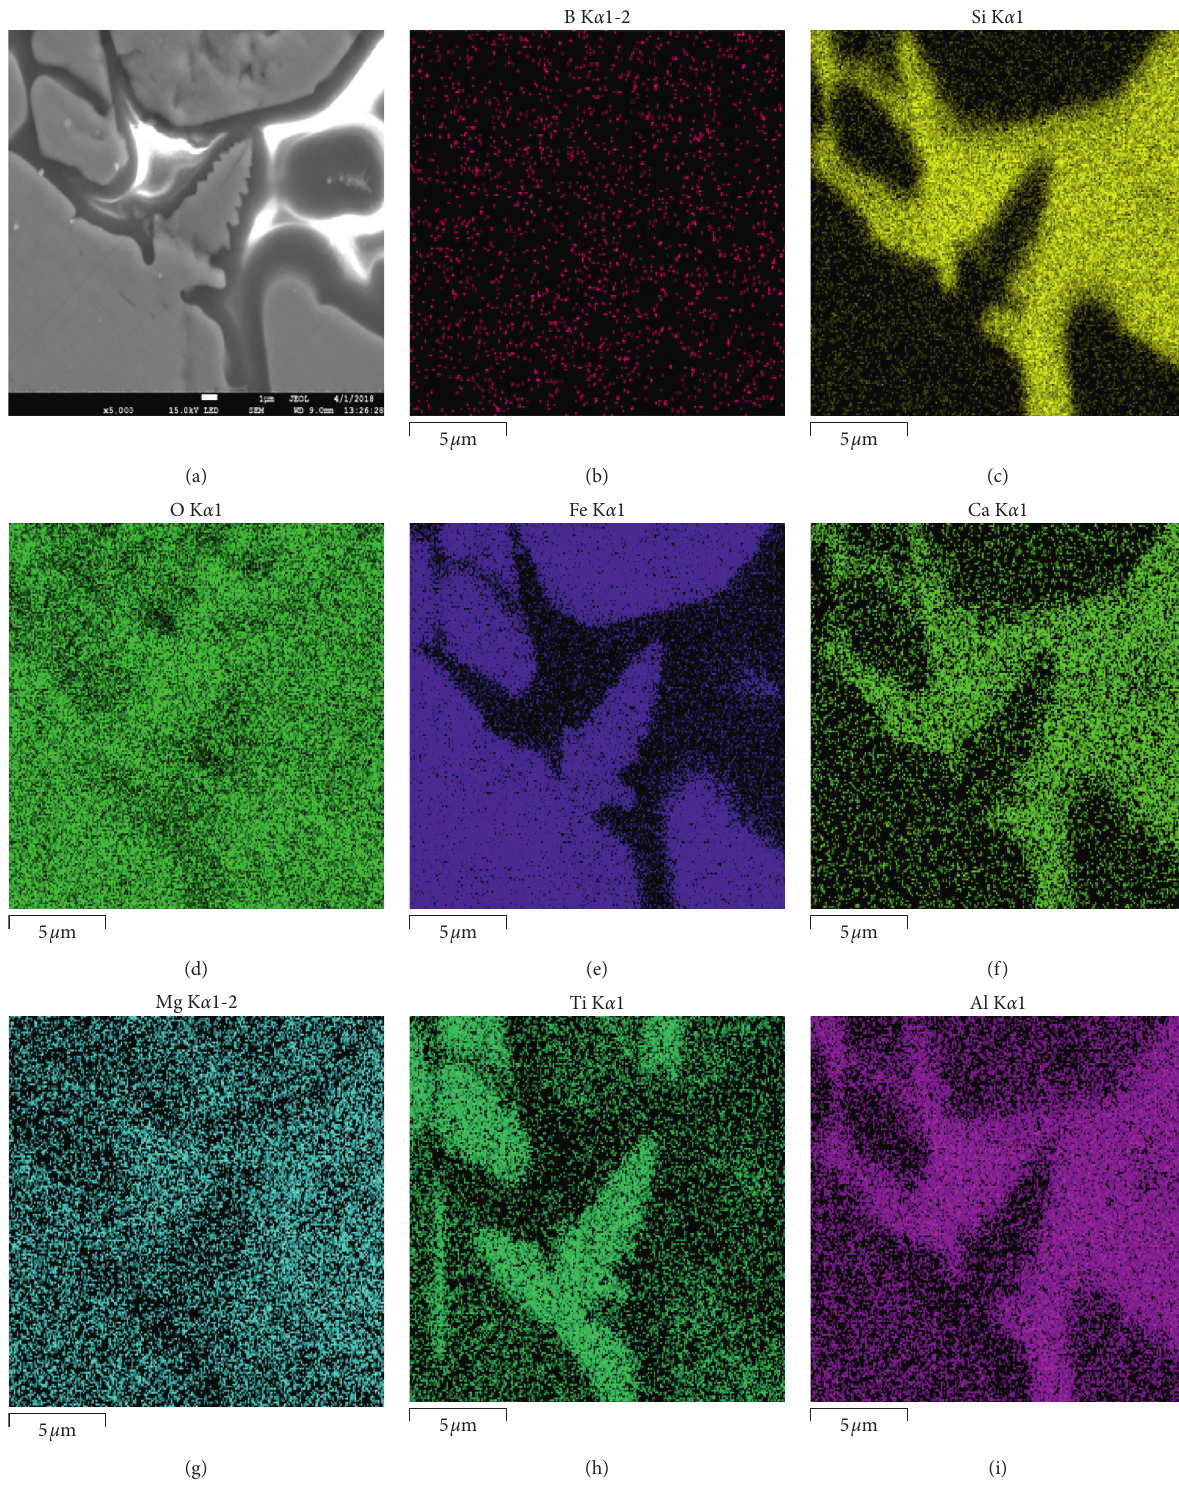
Figure 10: SEM-EDS images of pellet at 2% B